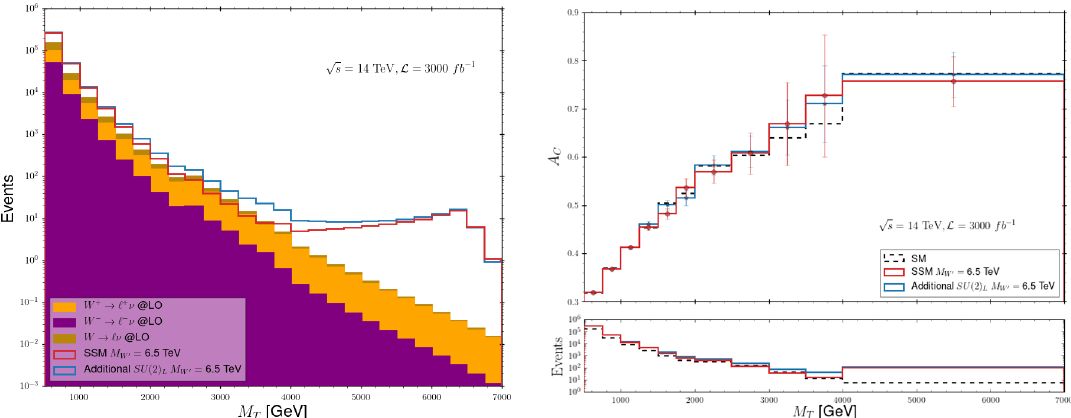
Figure 6 . Distribution in the transverse mass M T of the ‘ν system produced in CC Drell-Yan processes at the HL-LHC (left panel). We show predictions for the SM (olive), as well as for the SSM (red) and for models with an additional SU(2) L symmetry (blue). In the case of the SM, we distinguish the production of a positively-charged (purple) and negatively-charged (yellow) ‘ν system. The corresponding charge asymmetries are shown in the right panel of the figure, together with the associated statistical uncertainties. In the lower panel of the right subfigure, we show the number of events populating a given bin, which is related to the associated uncertainty according to eq.